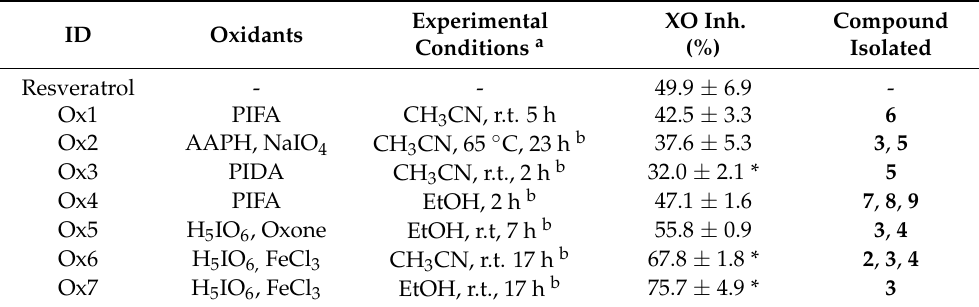
Table 1. Oxidation of resveratrol, XO inhibitory activity of the oxidized mixtures, and list of com- pounds isolated from each. Results are expressed as mean ± SEM, n = 3; *: p < 0.05 by one-way ANOVA using Dunnett’s multiple comparison test to the parent compound resveratrol. Resveratrol was tested at 100 µ M, and mixtures Ox1–Ox7 at 100 µ M of resveratrol equivalents. Experimental XO Inh. Compound ID Oxidants Conditions a (%) Isolated Resveratrol - - 49.9 ± 6.9 - Ox1 PIFA CH 3 CN, r.t. 5 h 42.5 ± 3.3 AAPH, NaIO 4 CH 3 CN, 65 ◦ C, 23 h b PIFA EtOH, 2 h b H 5 IO 6 , Oxone EtOH, r.t, 7 h b 55.8 ± 0.9 H 5 IO 6, FeCl 3 CH 3 CN, r.t. 17 h b 67.8 ± 1.8 * H 5 IO 6 , FeCl 3 EtOH, r.t., 17 h